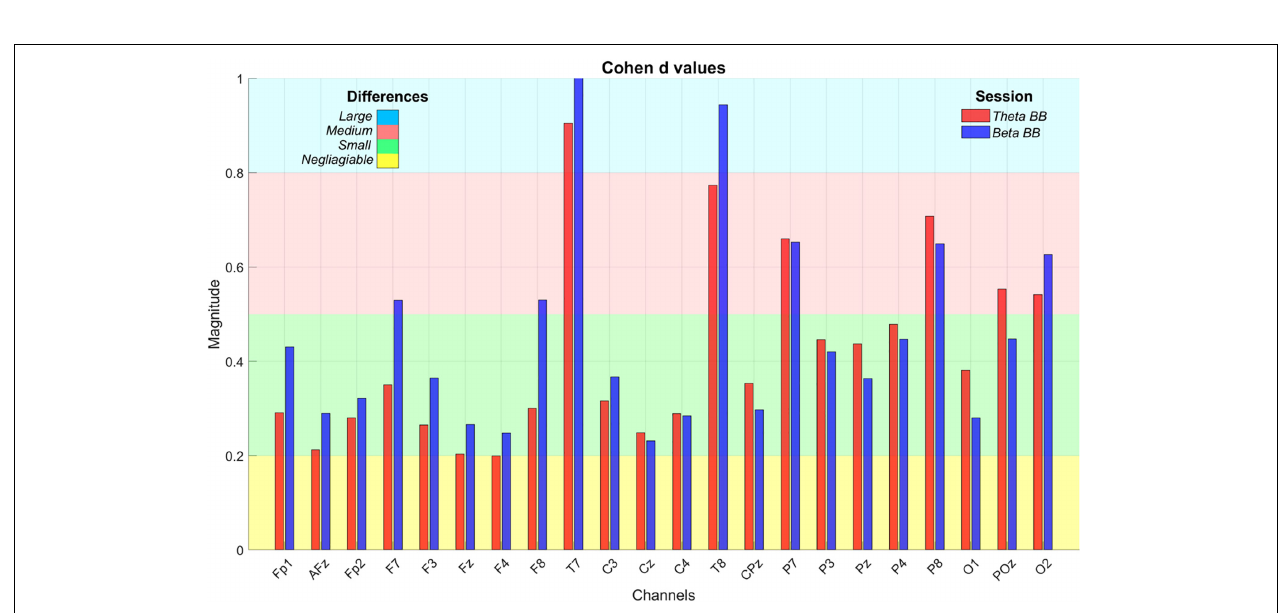
FIGURE 6 | Cohen’s d effect size values. The bar plot depicts Cohen’s d values to estimate the magnitude of statistical differences in absolute power when S1 (red bar) and S2 (blue bar) were compared with S R . X -axis exhibits EEG channels whereas Y -axis is the Cohen’s d value, ranging from 0 to 1. The colored background regions represent the intervals to specify the magnitude of the differences throughout channels and between sessions, such as negligible (yellow), small (green), medium (red), and large (blue).